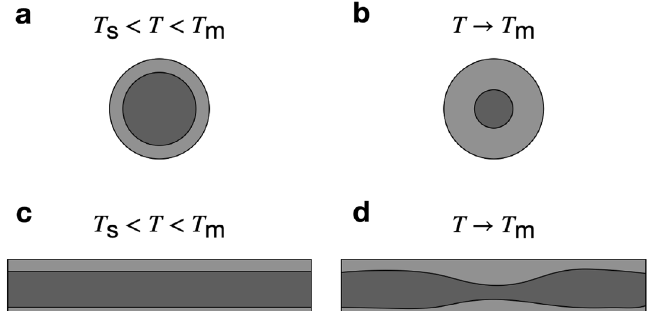
Figure 1. Two different melting modes of nanowires where light grey represents the liquid, while dark grey represents the solid. Panels ( a )–( b ) represent the moving interface front mechanism, whereas panels ( c )–( d ) show melting initiated via an instability at the solid-liquid